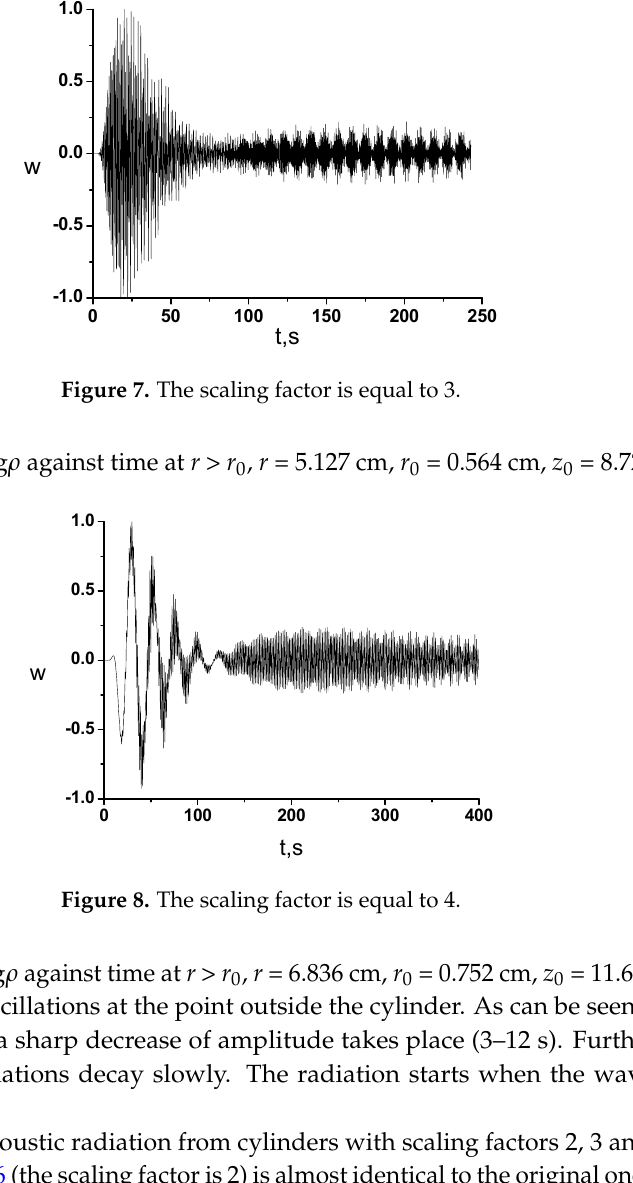
Figure 6. The scaling factor is equal to 2.